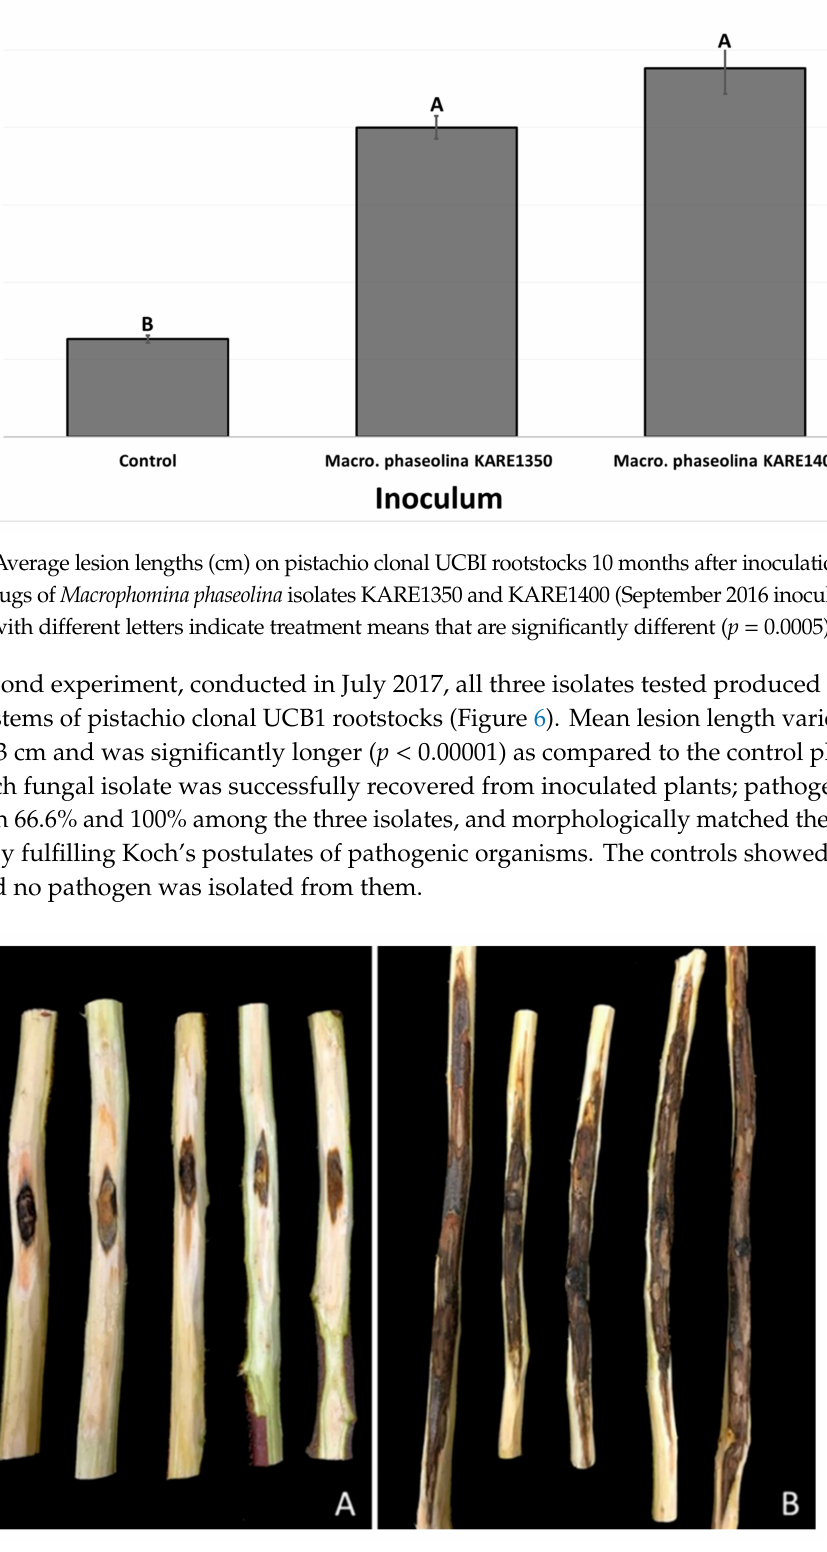
Figure 6. Lesions produced in 2-year-old potted clonal UCBI rootstocks, 10 months after inoculation: ( A ) Control; ( B ) Macrophomina phaseolina isolate KARE1400 (July 2017